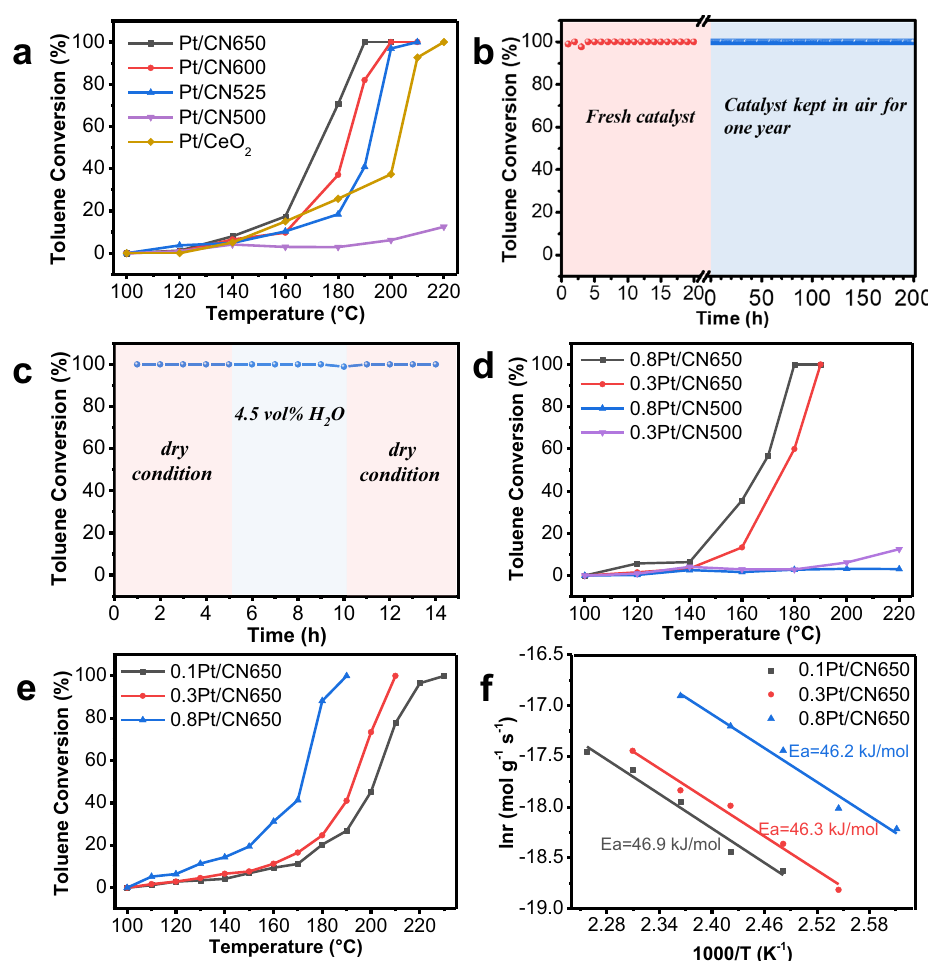
Fig. 4 Catalytic activities of toluene oxidation over different supported Pt catalysts. a Toluene conversion as a function of temperature, Pt loading amount 0.3 wt%, reaction conditions: C 7 H 8 1000 ppm, space velocity (SV) = 24,000 mL g − 1 h − 1 , air balance. b Stability test of Pt/CN650 for toluene oxidation, reaction temperature: 190 °C, the other reaction conditions are the same as a . c In fl uence of gas-phase water on toluene oxidation over Pt/ CN650, H 2 O 4.5 vol%, the other reaction conditions are the same as b . d Toluene conversion over Pt/CN650 and Pt/CN500 with different loading amount of Pt, reaction conditions are the same as a . e Toluene conversion as a function of temperature over Pt/CN650 with different loading amount of Pt at SV of 60,000mL g − 1 h − 1 , the other reaction conditions are the same as a . f Arrhenius plots for toluene oxidation over Pt/CN650 with different loading amount of